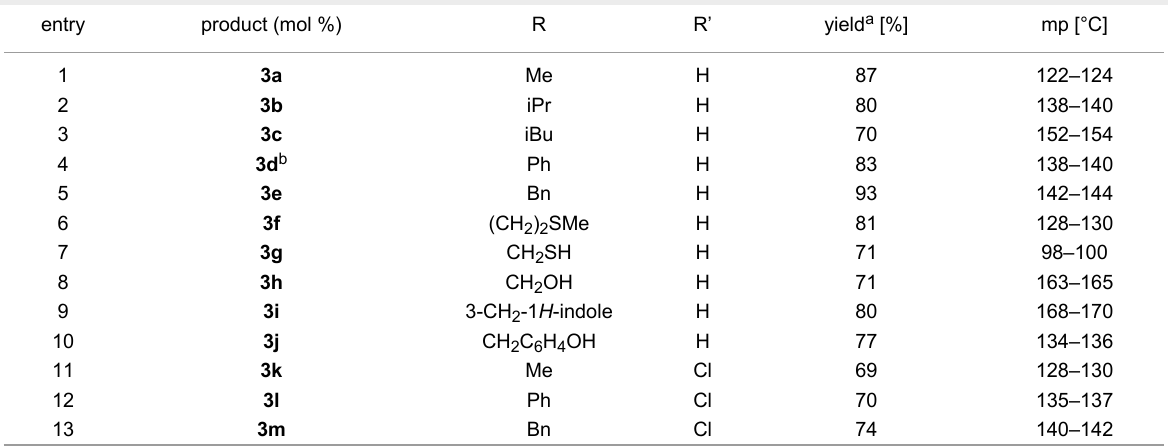
Table 1: Synthesis of the α -amino acid arylhydrazides 3a – m .